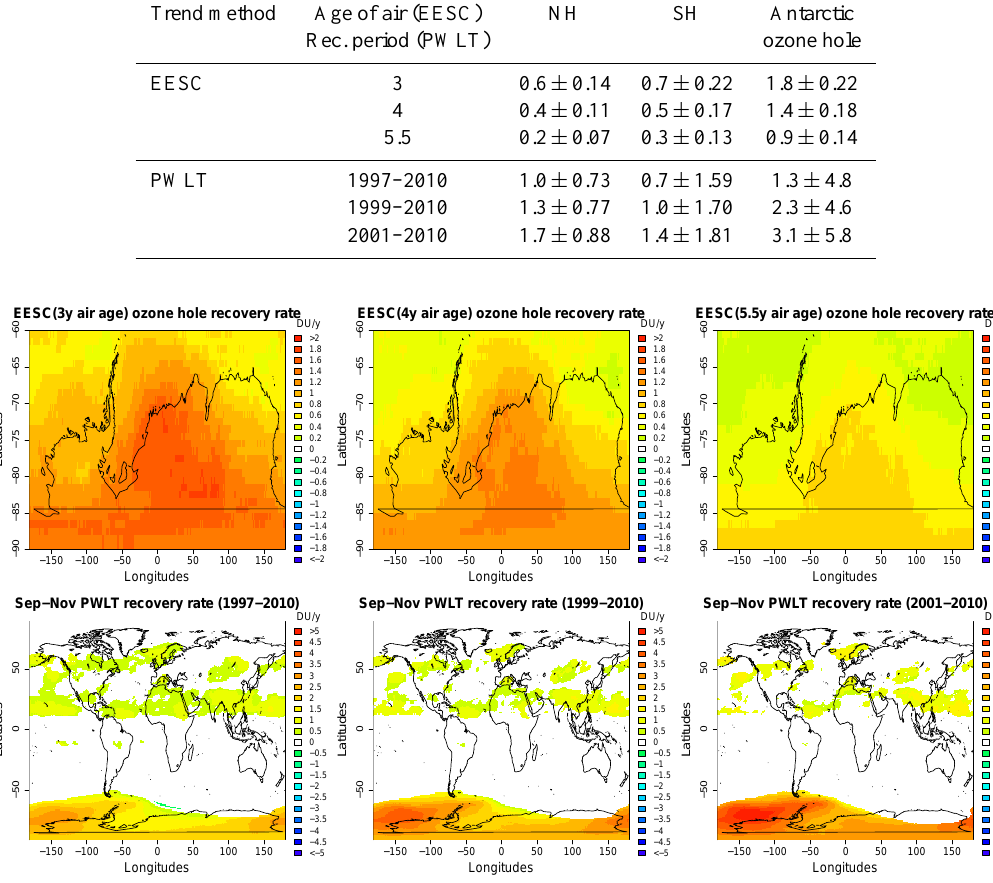
so that ozone at higher latitudes has been affected by